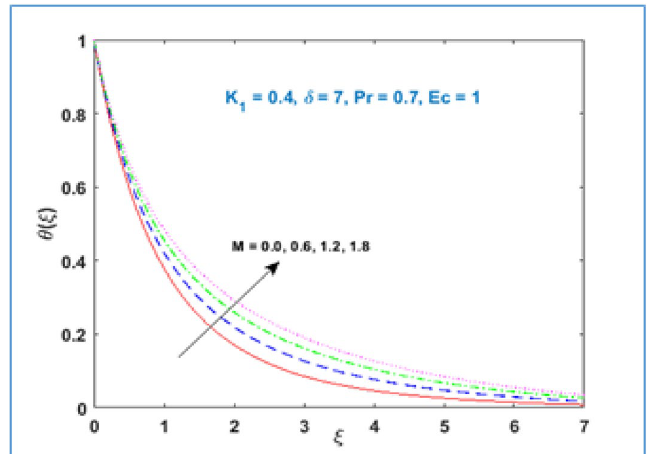
Figure 9. θ(ξ) versus M